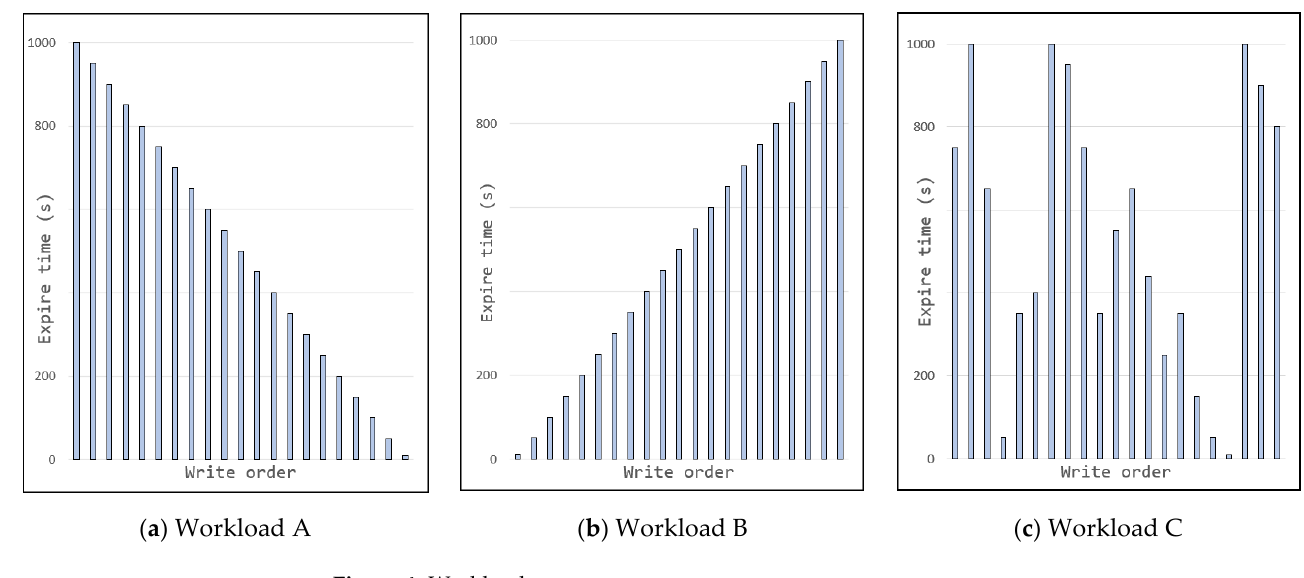
Figure 4. Workload setup.